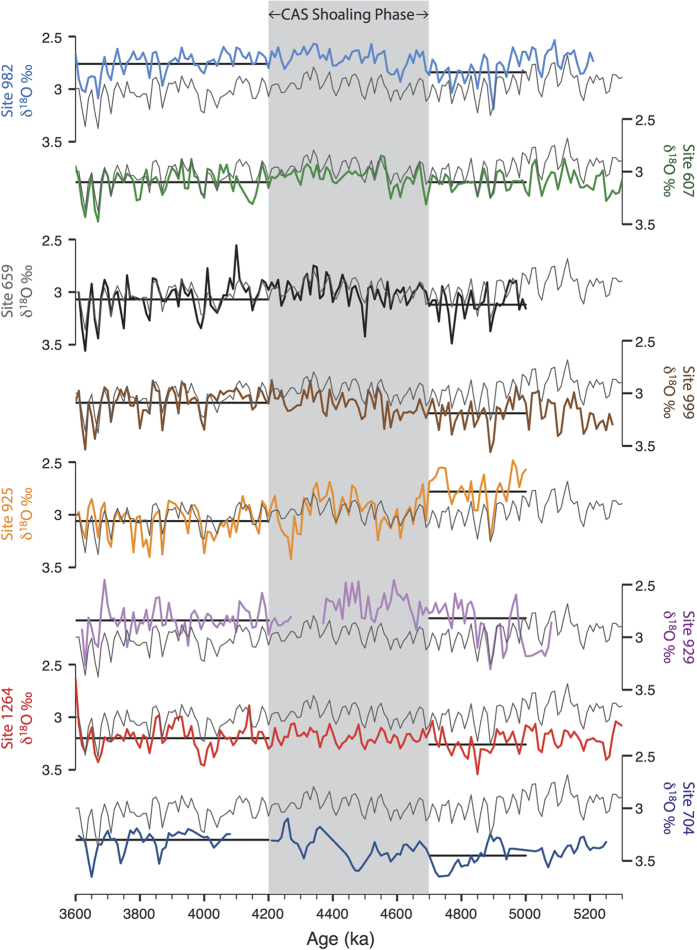
Time series δ18O data (‰ vs Vienna Pee Dee Belemnite) from all sites shown in Fig. 1 (thick colored lines).Data has been resampled at common 10 kyr time steps (linear integration). Horizontal thick black lines show average δ18O values for the time slice intervals 5.0–4.7 Ma (Pre CAS shoaling) and 4.2–3.6 Ma (Post CAS shoaling). The LR04 stack38 is shown along side each record (thin gray lines), on the same scale, to show stratigraphic alignment (see Methods). Note that data from Site 1264 has been resampled at 3 kyr intervals so that stratigraphic alignment can be clearly seen, while Site 704 prior to 4.2 Ma is displayed as symbols in order to highlight the low resolution and stratigraphic uncertainty. References for isotopic data are given in Table 1.